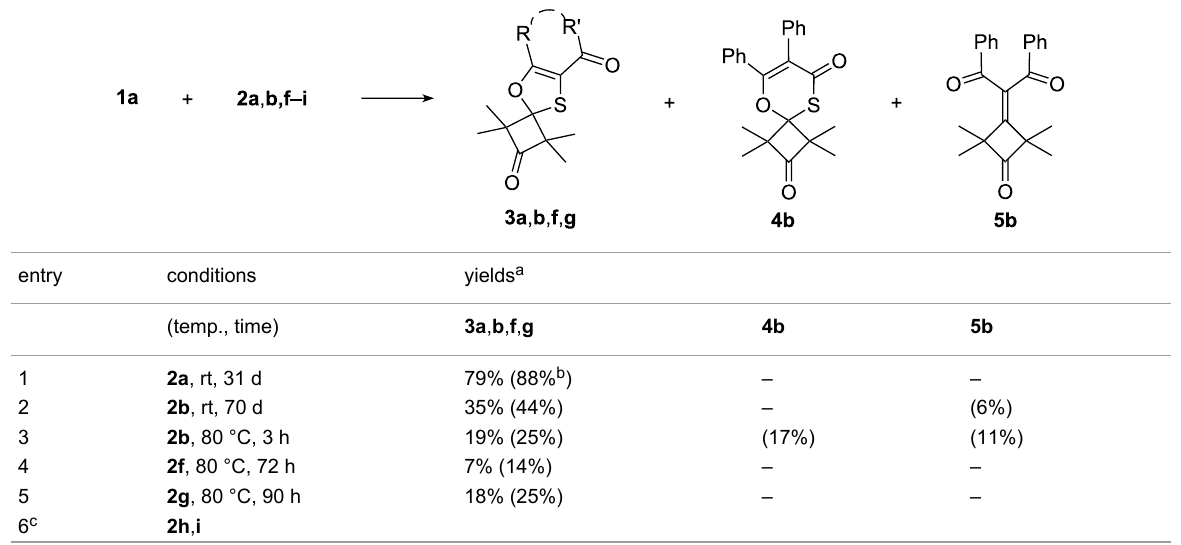
nor the corresponding acylketenes generated by their thermol- ysis [18,19] reacted with thioketone 1a (as proved by 1 H NMR spectroscopy) (Table 1, entry